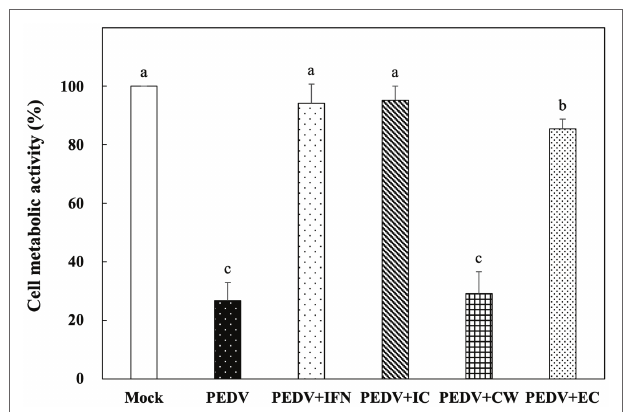
FIGURE 4 | In vitro prophylactic effects of intracellular extracts, cell-wall fractions, or extracellular supernatants of Ln. mesenteroides YPK30 against PEDV infection in Vero cells. Bar chart showing percentage of cell metabolic activity of six sample conditions: (1) Mock: cells pretreated with PBS and then mock-infected with PBS, (2) PEDV: cells pretreated with PBS and then infected with PEDV, (3) PEDV+IFN: cells pretreated with IFN- α 2b and then infected with PEDV, (4) PEDV+IC: cells pretreated with the intracellular extracts of Ln. mesenteroides YPK30 and then infected with PEDV, (5) PEDV+CW: cells pretreated with the cell-wall fractions of Ln. mesenteroides YPK30 and then infected with PEDV, and (6) PEDV+EC: cells pretreated with the extracellular supernatants of Ln. mesenteroides YPK30 and then infected with PEDV. All data are expressed as mean ± SD ( n = 3). Bars marked with the same letter are not significantly different ( p > 0.05).